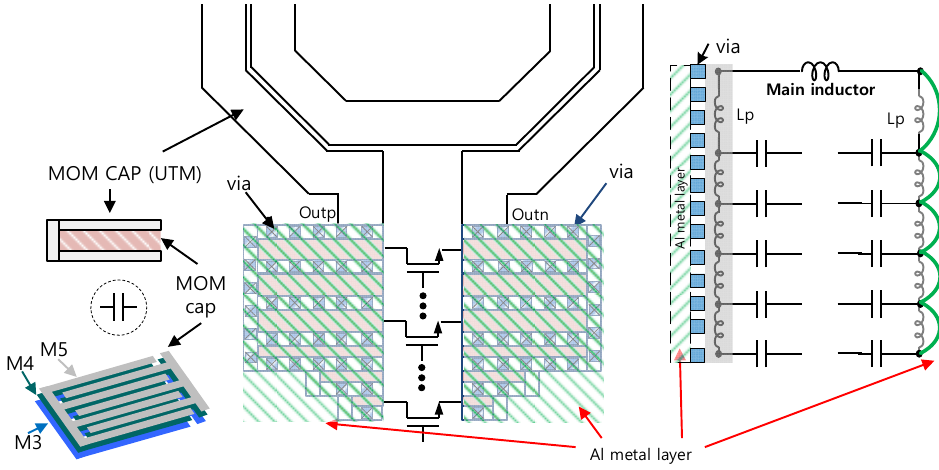
Figure 3. Layout and equivalent circuit using a metal Al layer.